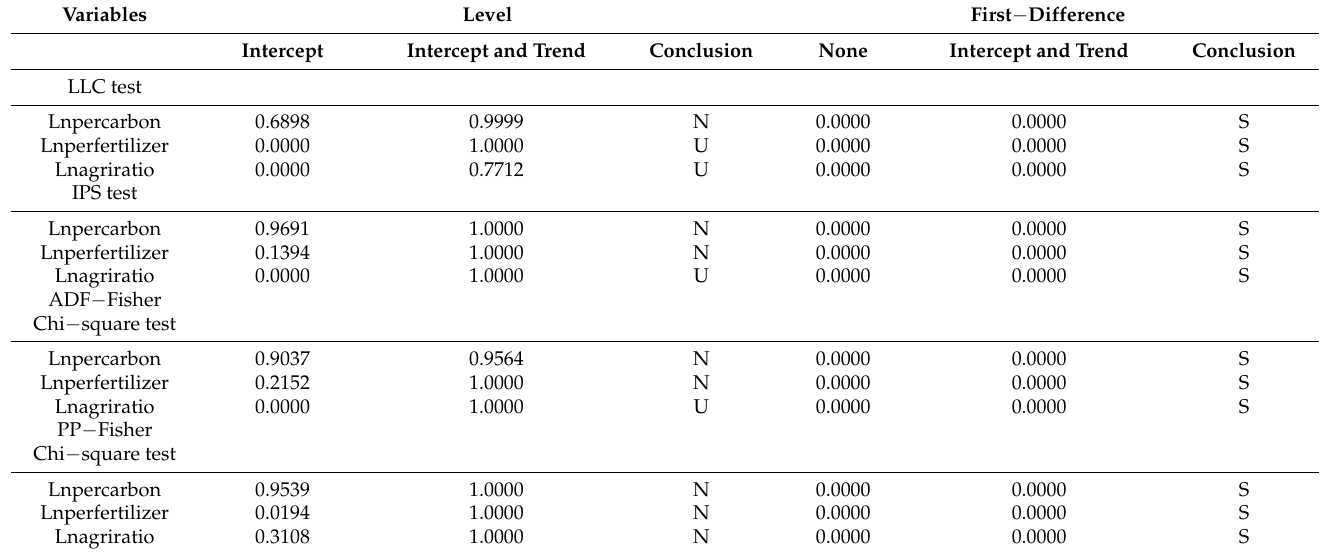
Table 4. The results of unit root